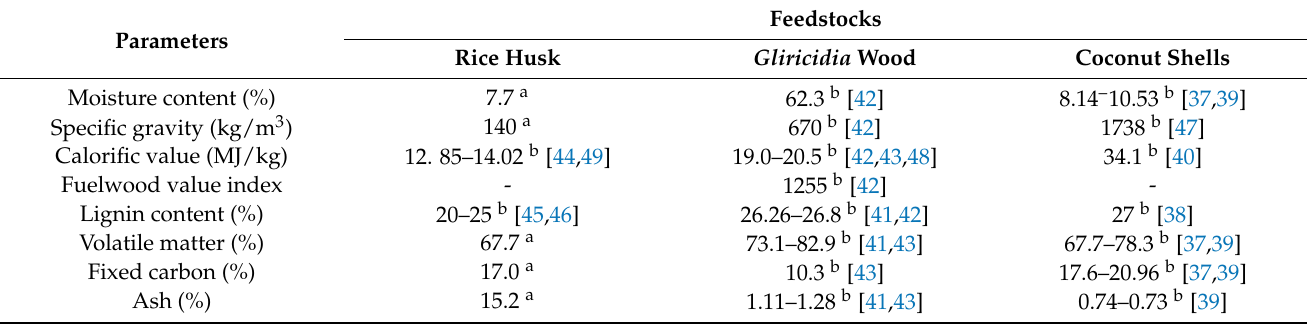
Table 3. Characterization of the feedstocks [34,37–49].